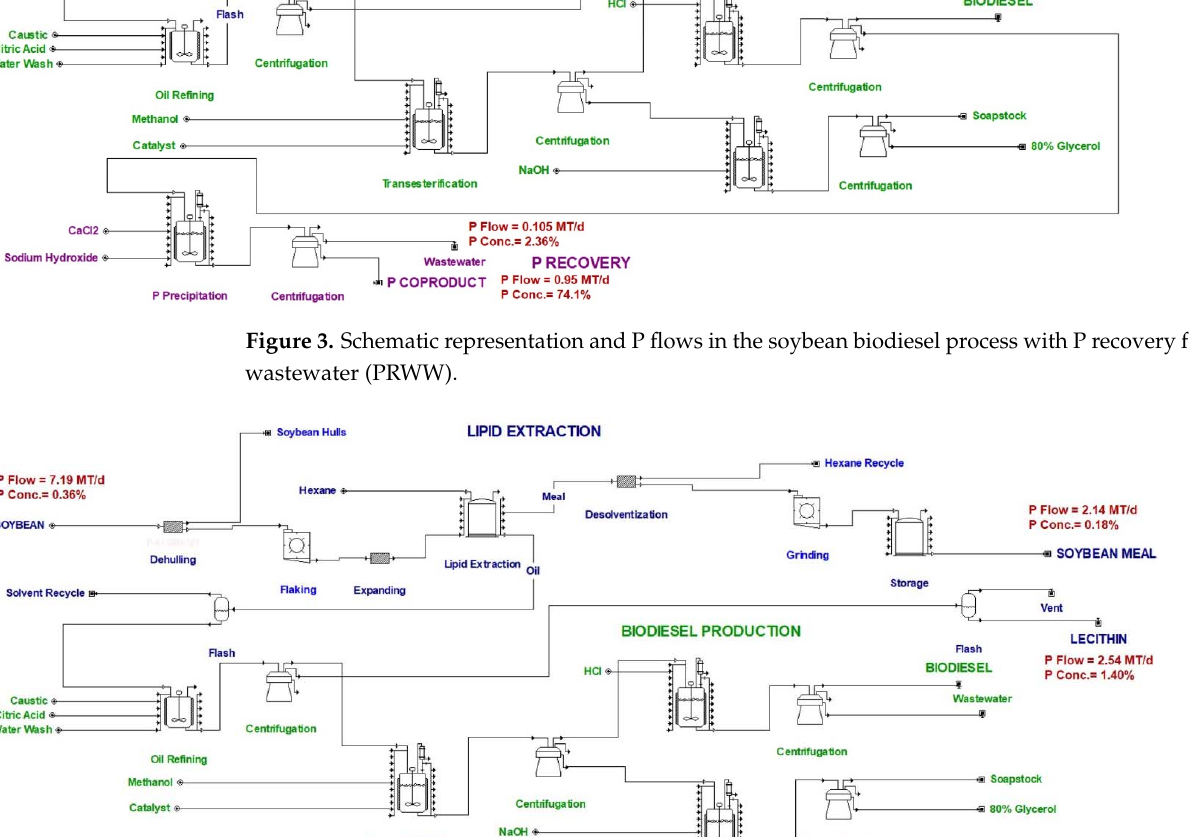
Figure 3. Schematic representation and P flows in the soybean biodiesel process with P recovery from wastewater (PRWW).